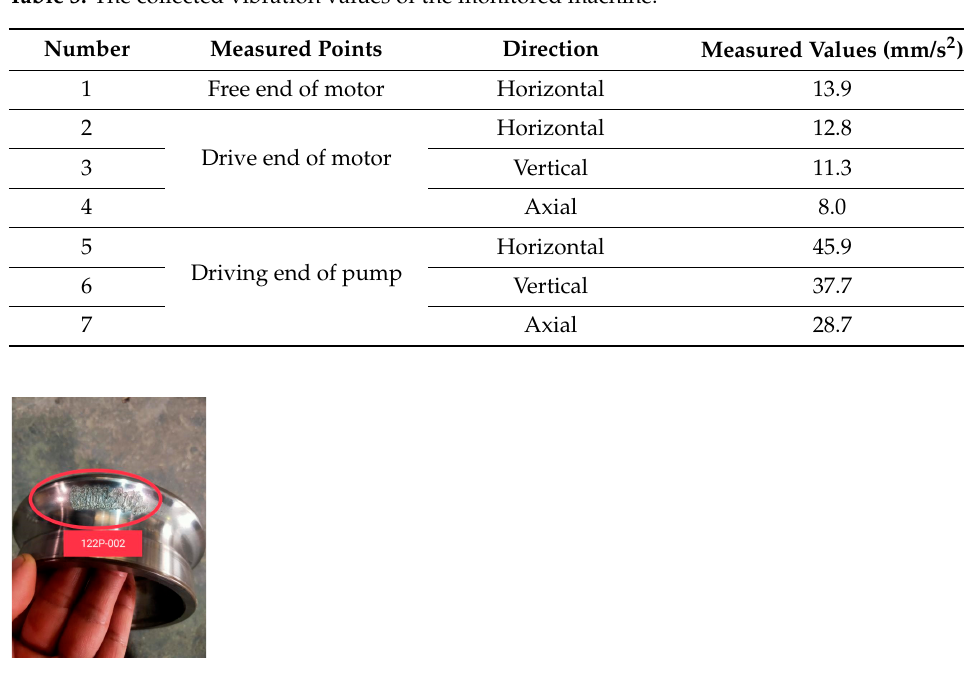
Figure 9. The actual faulty component of the engineering bearing. Table 4. Fault characteristic frequencies. Table 3. The collected vibration values of the monitored machine.